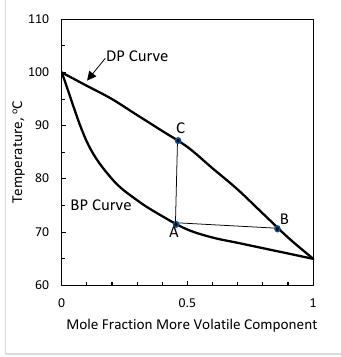
Figure 1. Equilibrium curve of a typical binary mixture.